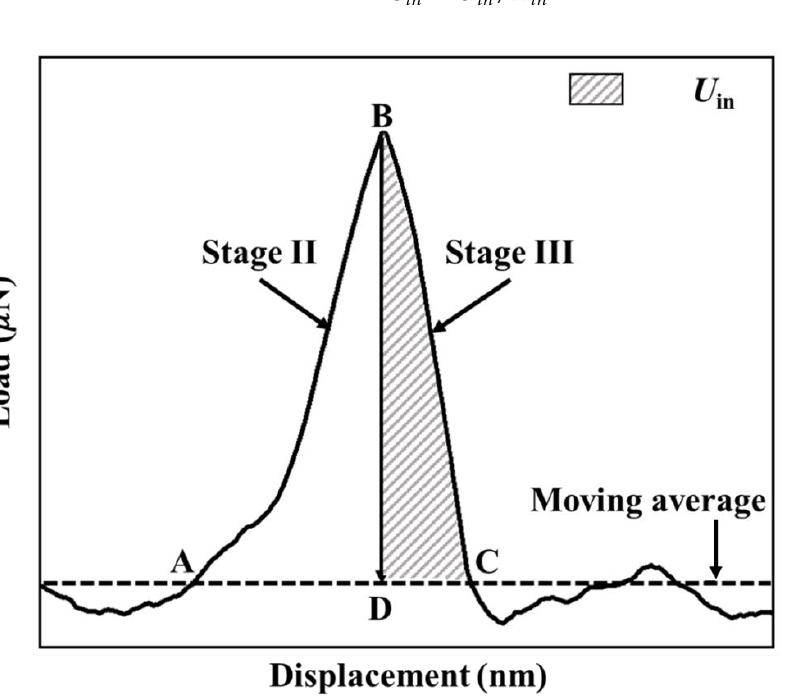
Figure 7. The P–h curve of a push-out test, where the shaded area (DBC, Stage III) gives the energy U in associated with the delamination event, while area ABD (Stage II) gives the energy used in deflecting the Au/SiN/GaAs multilayer panel.